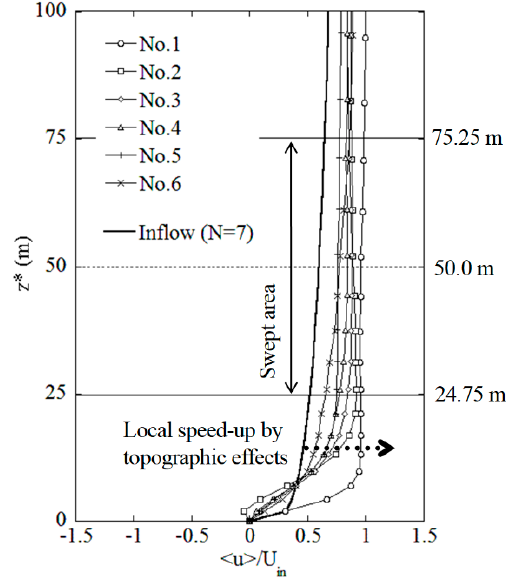
Figure 7. Profile of mean streamwise wind velocity at each wind turbine site.